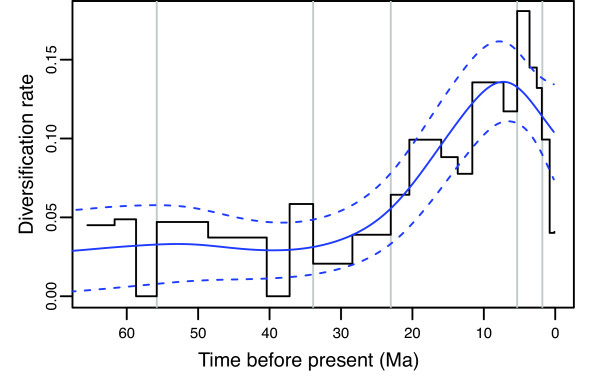
Net diversification rates through time across all carnivores. Rates were localized to bins of 0.25 Ma (stepped line) or modeled as a function of time using generalized additive models (solid curve with 95% confidence intervals presented as dashed curves).